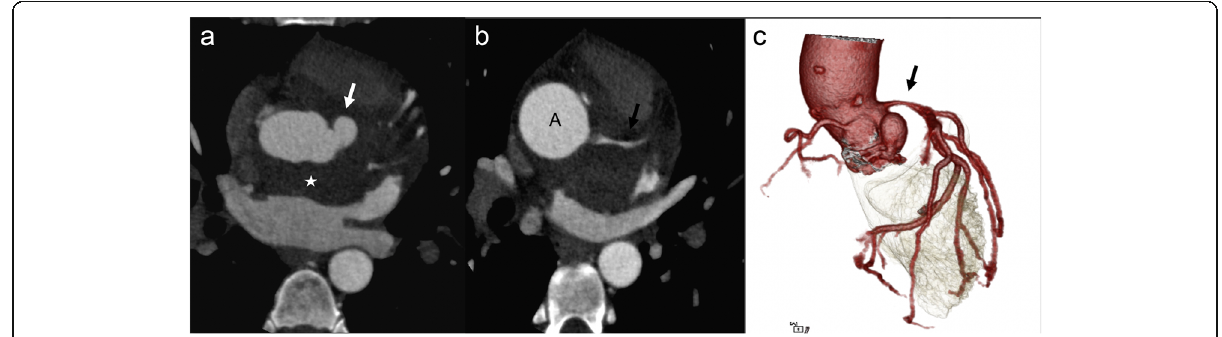
Fig. 10 A 33-year-old male with a history of intravenous drug abuse with infectious endocarditis status post aortic valve replacement, presenting with fever. Axial ( a and b ) and volume-rendered ( c ) CTA images showing soft tissue (star) between the aortic root and the left atrium consistent with a paraaortic abscess. A pseudoaneurysm (white arrow) is also seen, and there is a mass effect on the left main coronary artery (black